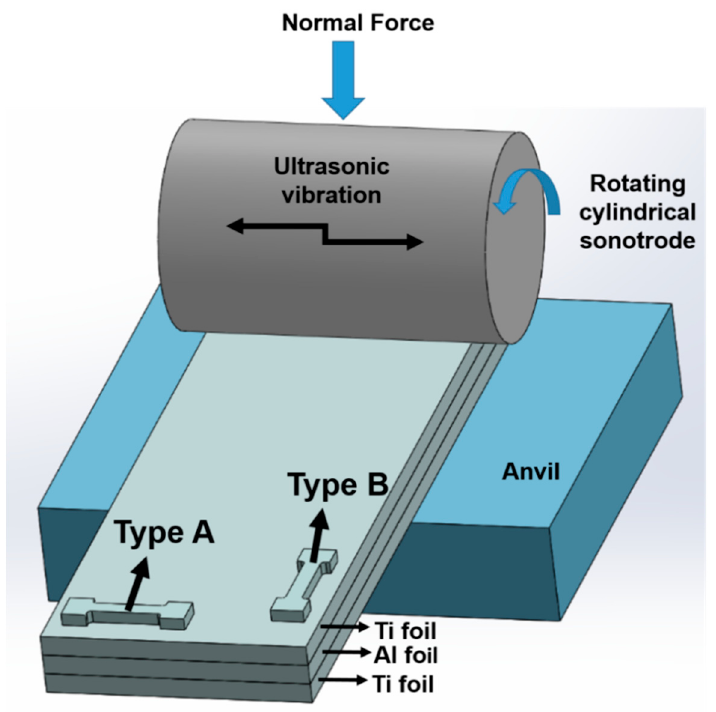
Figure 1. Schematic illustration of UC and test sample extractions.